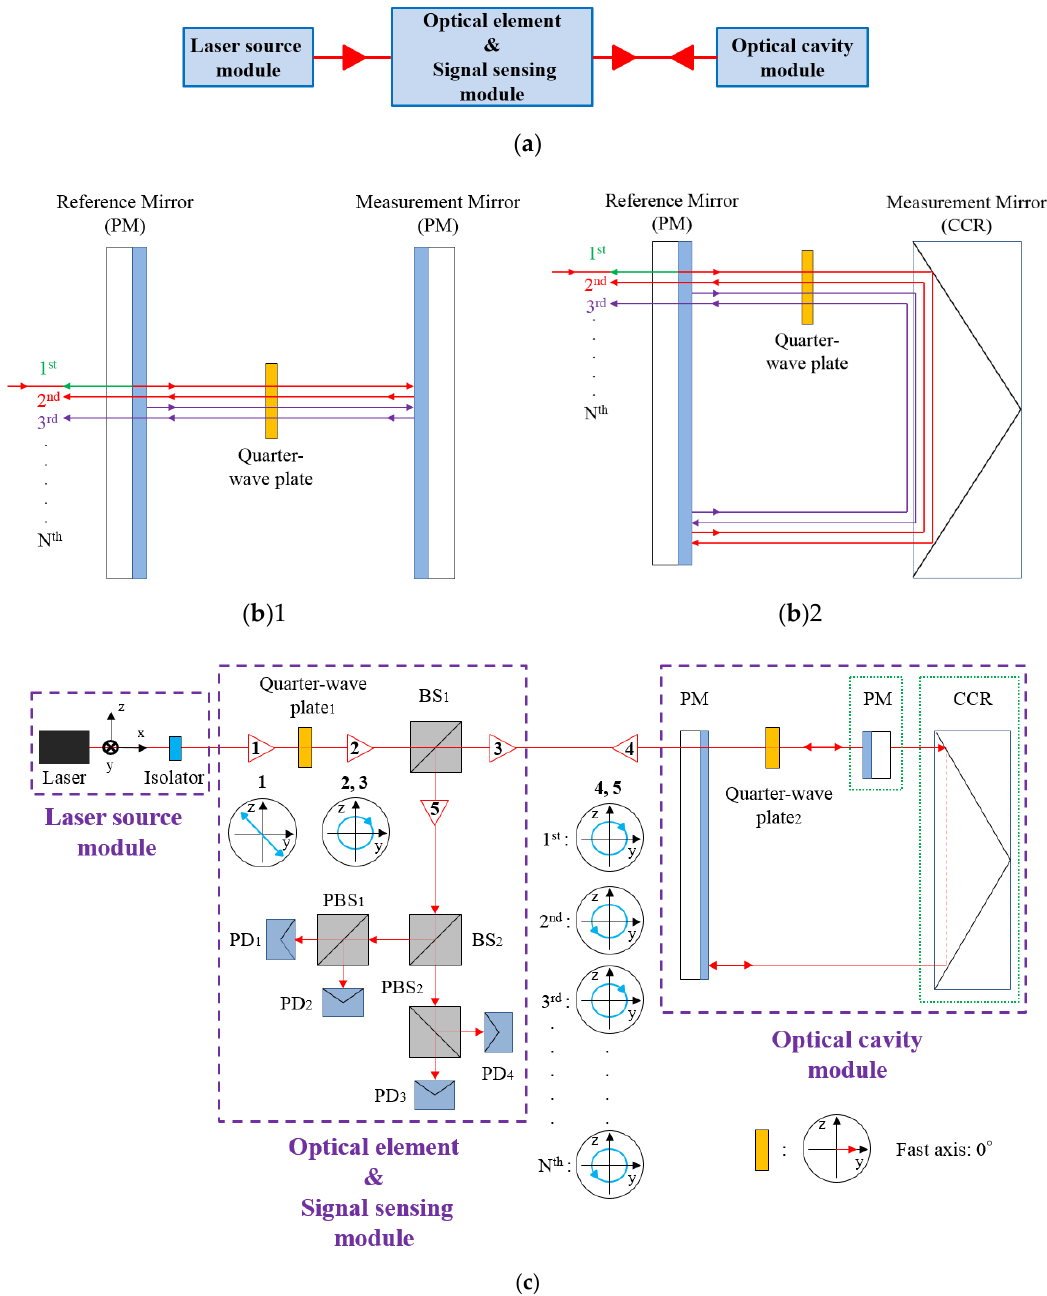
Figure 5. Proposed differential quadrature Fabry–Pérot interferometer: ( a ) Structure composition; ( b ) transmission of laser beams in two measurement types ( b )1 plane mirrors (PM) type, ( b )2 cube retro-reflector (CCR) type, ( c ) optical arrangement and the polarization direction of laser beams. PD, photodiode, PBS, polarizing beam splitter; BS, non-polarizing beam splitter.